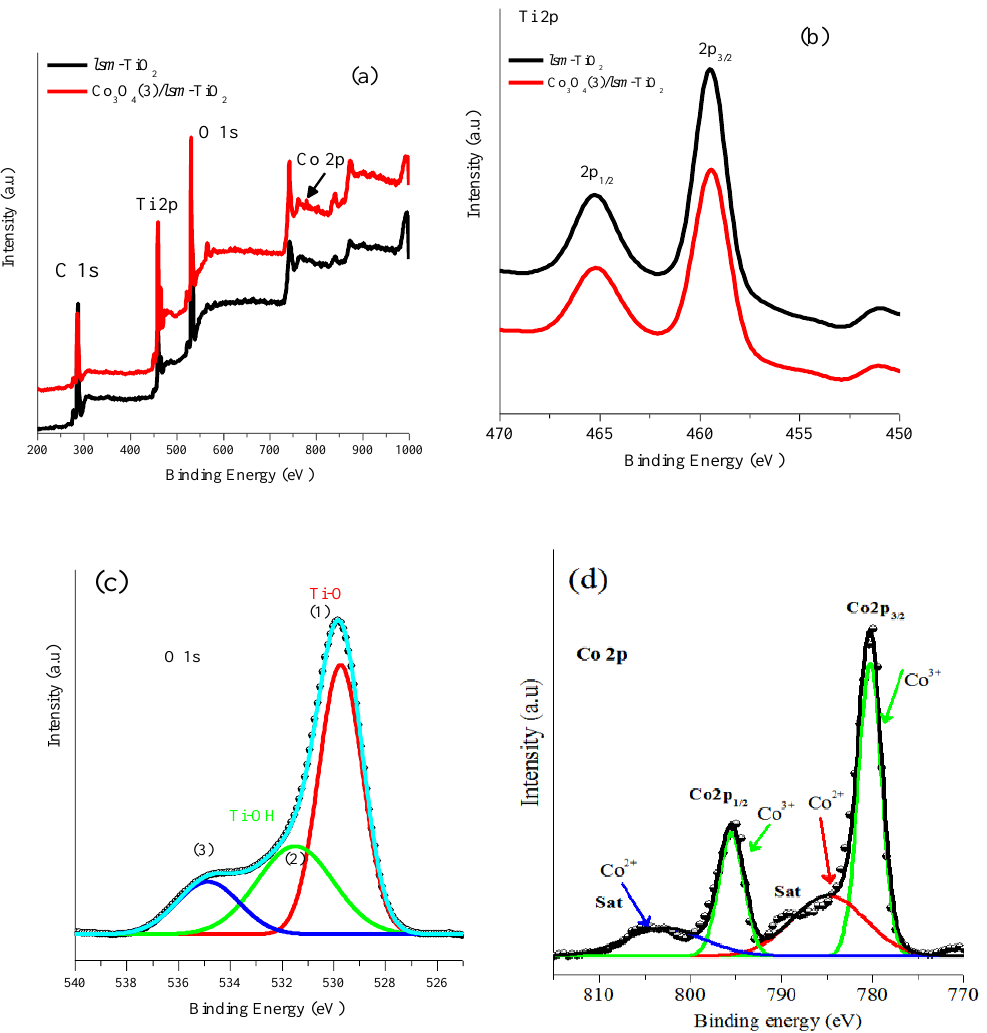
Figure 3. ( a ) The XPS survey spectra of pristine lsm -TiO 2 and Co 3 O 4 (3) / lsm -TiO 2 hybrids, ( b ) core spectra of Ti 2p for lsm -TiO 2 and Co 3 O 4 (3) / lsm -TiO 2 catalysts, ( c ) O 1s of Co 3 O 4 (3) / lsm -TiO 2 catalyst, and ( d ) Co 2p core-levels.